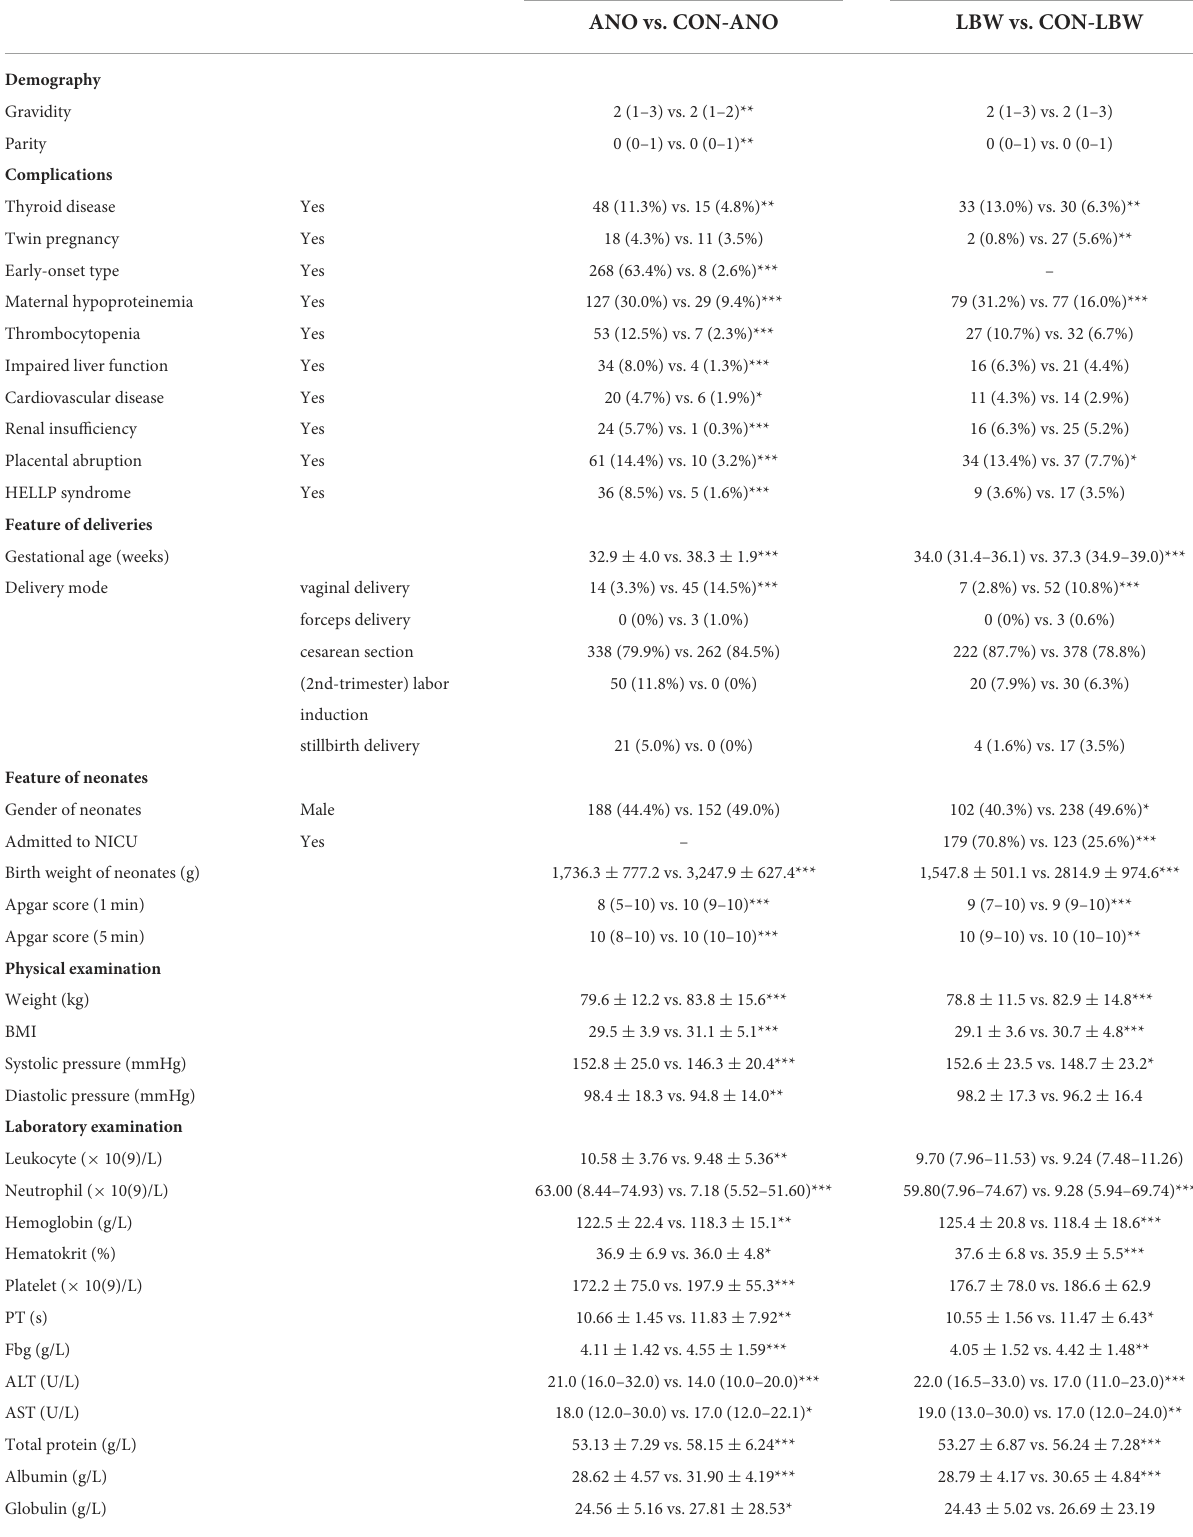
TABLE 5 Variables with statistical significance between adverse neonatal outcomes group and control group.